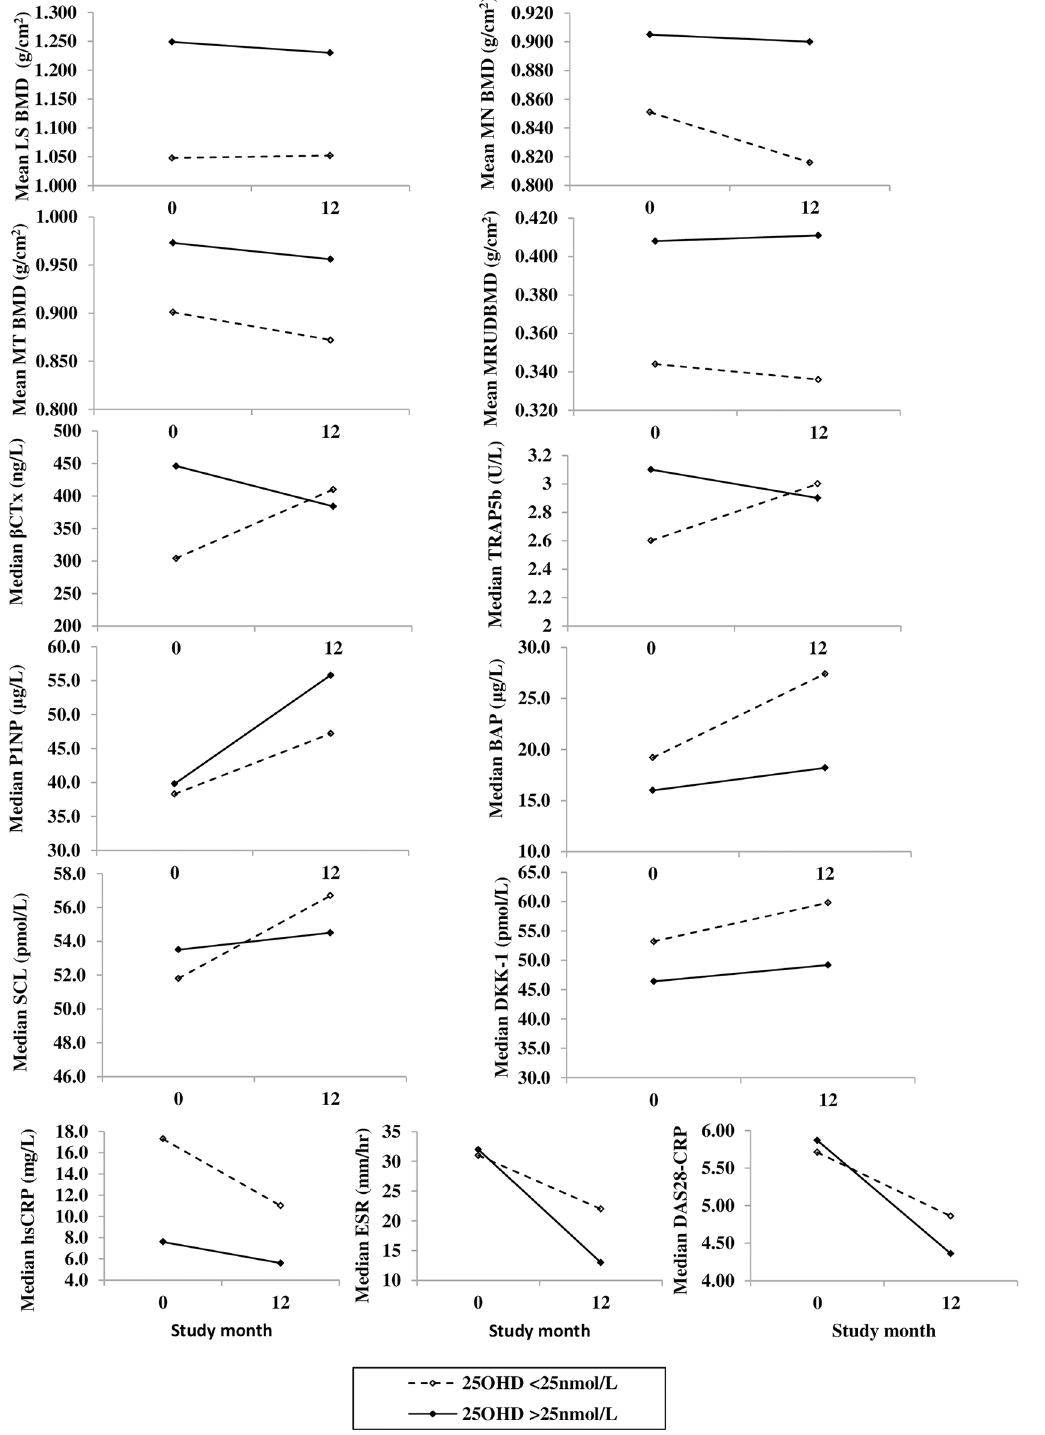
Fig 4. The effects of vitamin D on mean bone mineral density and median levels of biomarkers.